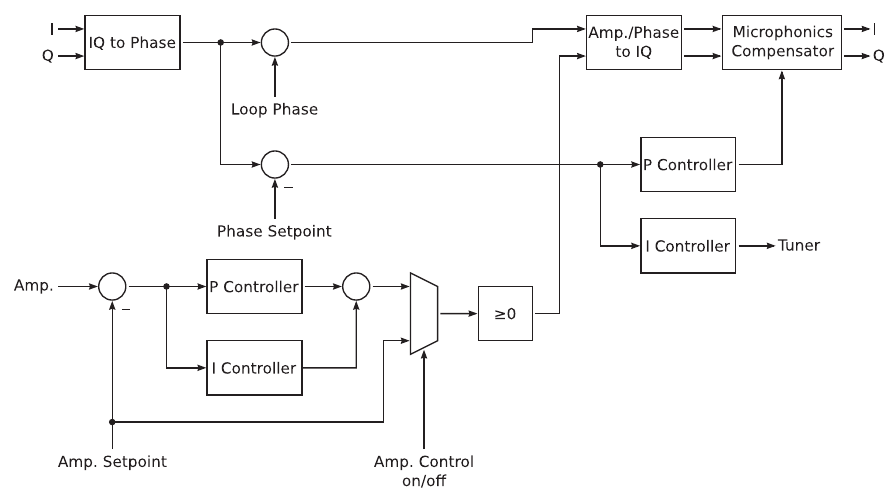
FIG. 3. Simplified flow chart of the self-excited loop control algorithm used with the superconducting cavities. In contrast to the GDR algorithm, the SEL algorithm passes through the phase-shifted input signal. A correction to this signal is applied by the microphonics